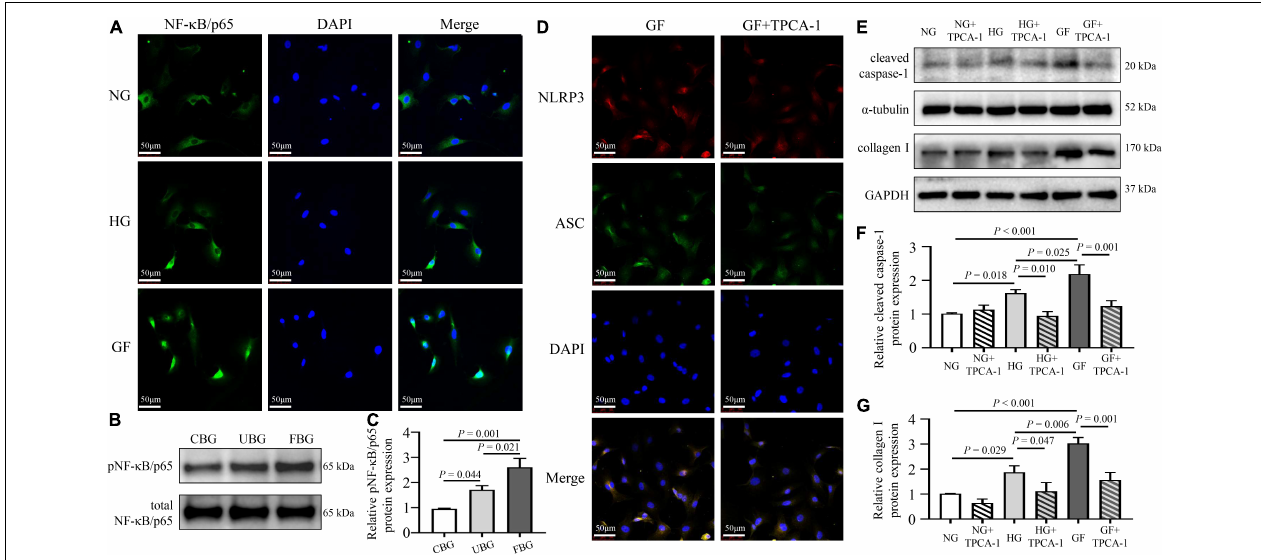
FIGURE 5 | Role of NF- κ B in glucose fluctuation-induced inflammasome-related myocardial fibrosis. (A) Immunofluorescence staining of NF- κ B/p65 nucleation ( n = 3 per group). (B,C) The phosphorylation level of NF- κ B/p65 in rat hearts of the three groups ( n = 4 per group). (D) Immunofluorescence staining of intracellular NLRP3–ASC interaction in the GF and GF + TPCA-1 groups. The NRCFs were labeled with anti-NLRP3 (red), anti-ASC (green), and DAPI (blue) ( n = 3 per group). (E–G) After application of TPCA-1 (0.5 µ M), the protein expressions of cleaved caspase-1 and collagen I were measured by western blot ( n = 3 per group).